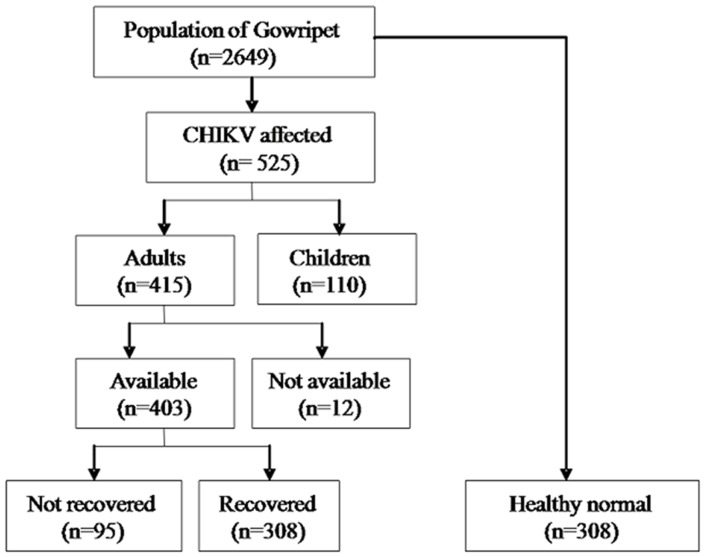
Selection of study participants.